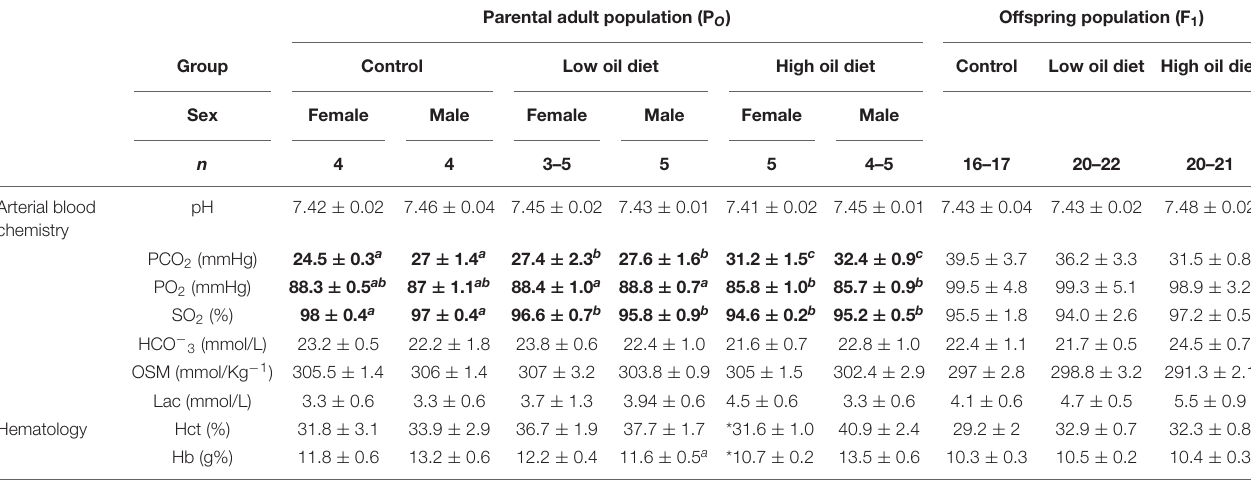
TABLE 1 | Blood chemistry and hematology in the parental adult populations (P O ), and in the first generation offspring populations (F 1 ) of king quail.